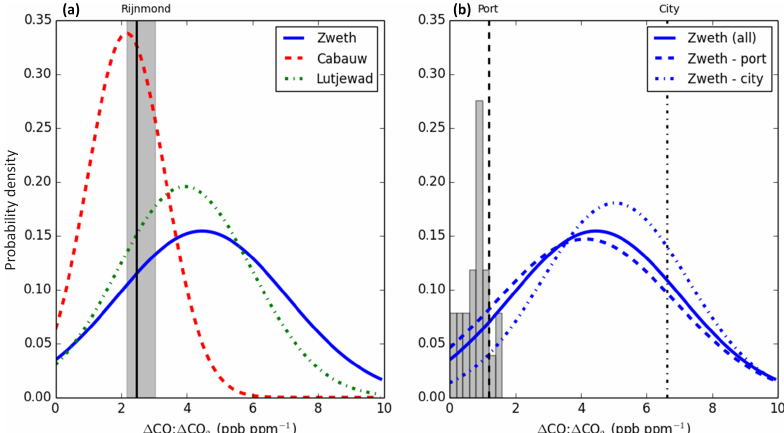
Figure 4. (a) Smooth Gaussian fit of probability density functions of observed (cid:49) CO : (cid:49) CO 2 at the Zweth, Cabauw and Lutjewad measure- ment sites. The solid vertical line (shaded area) shows the mean emission ratio (Q1–Q3 range) for all emissions integrated over the Rijnmond area (see Fig. 1). (b) The Zweth observations separated into two distinct source areas based on the observed wind direction. The dash–dotted and dashed vertical lines represent the mean emission ratios from the residential area and the port, respectively. Generally, there is a reason- able match between the bottom–up emission ratio and the concentration-derived ratio, but observed ratios from the Zweth–port wind sector are much higher than expected because of the intermittency of plume transport from the many stacks in this area. The grey bars in the right panel show the point source events selected in Sect.